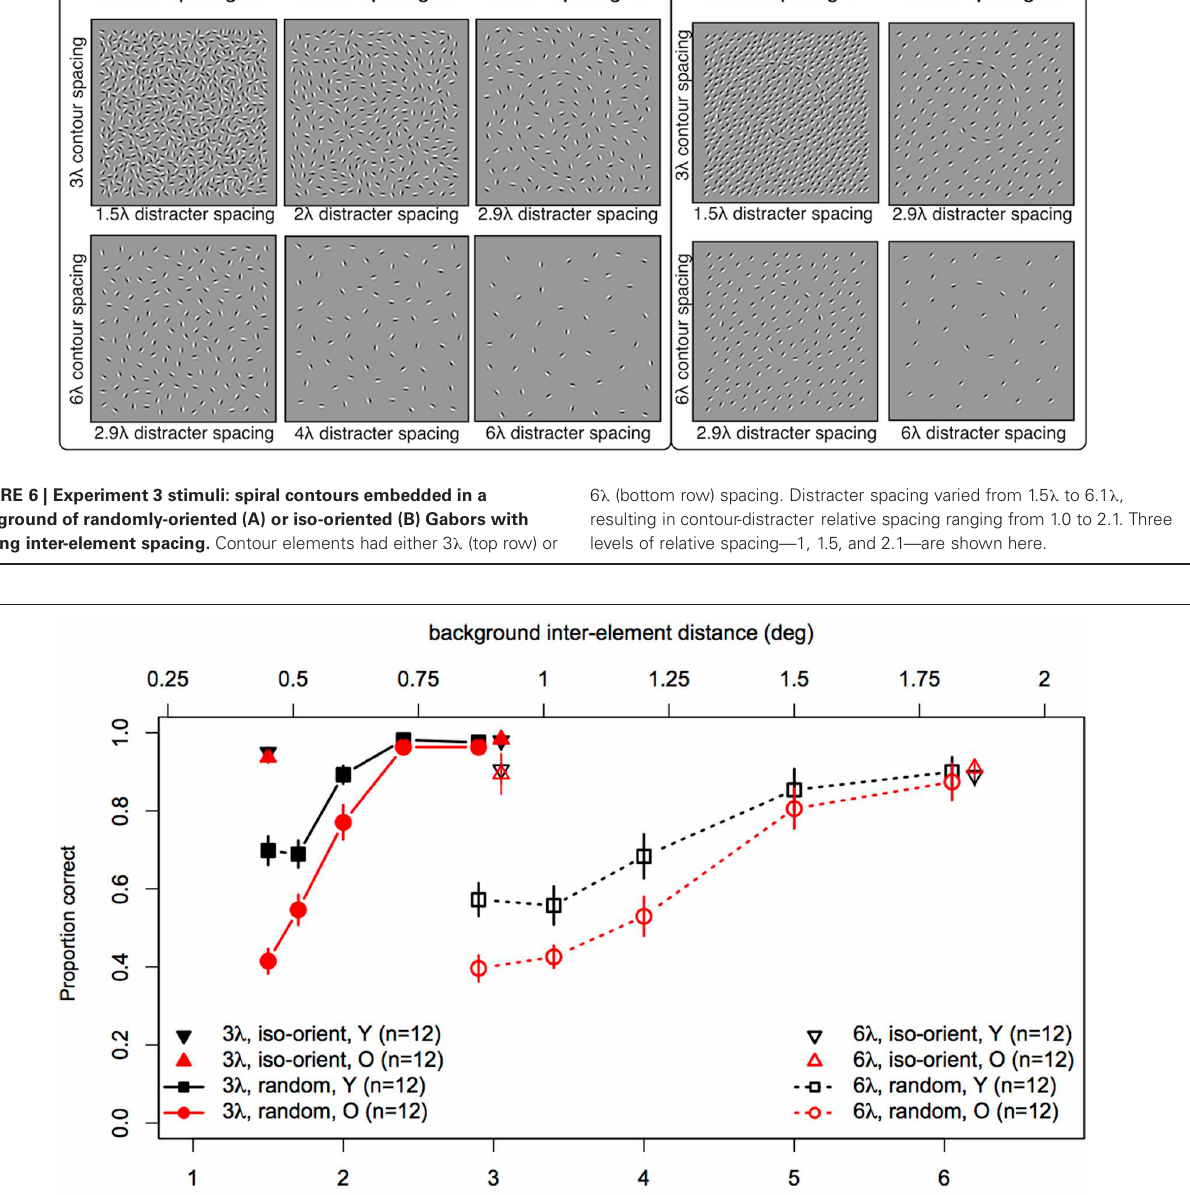
FIGURE 7 | Experiment 3 results: contour discrimination accuracy is shown as a function of background inter-element spacing for all conditions tested. Data for the iso-oriented background conditions are shown by the triangle symbols (up, black for younger subjects and down, red for older subjects). Black squares